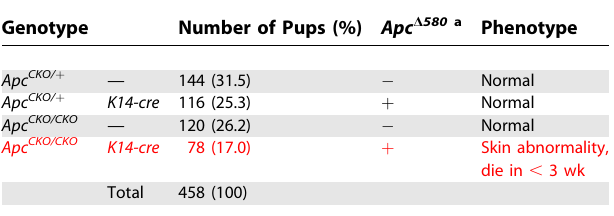
Table 1. Genotype Distribution of Progeny from the Matings